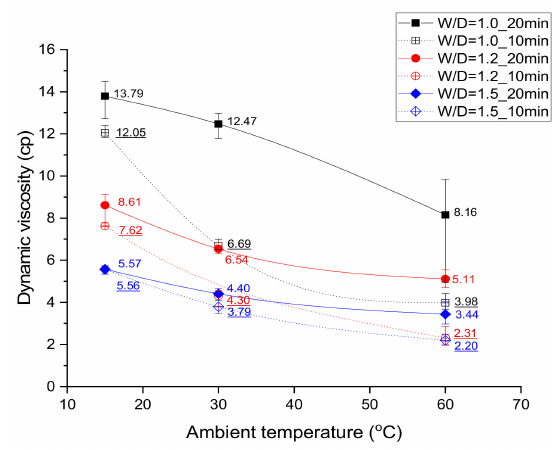
Figure 5. Viscosity changes by mixing time of W:D = 1.0, 1.2, and 1.5 emulsions.